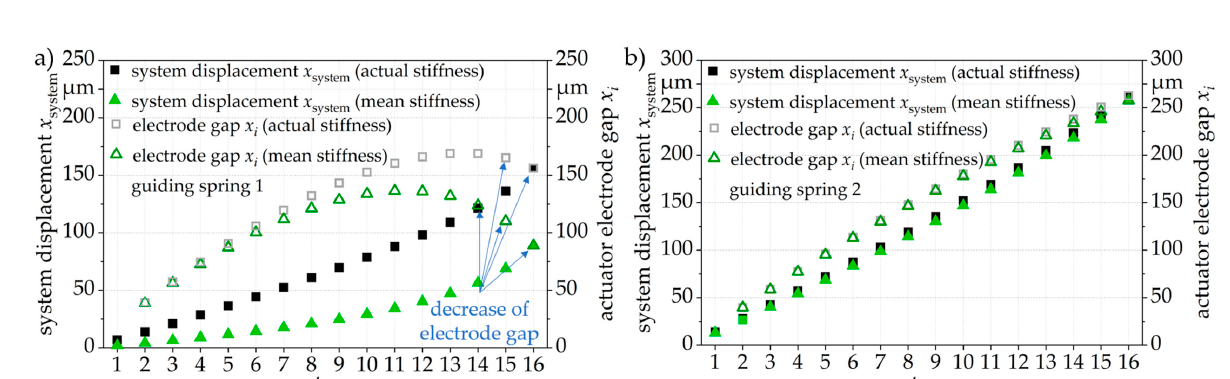
Figure 5. System displacement and electrode gap distance of 16-step systems depending on mean and actual stiffness value design guided by ( a ) guiding spring 1 (actual stiffness value: system 7 presented in Table 1), ( b ) guiding spring 2 (mean stiffness value: system 6 presented in Table 1). The values are obtained analytically (Equations (2) and (3)) by calculating with the spring stiffness values that are obtained by COMSOL simulation. The electrode gap amounts to 20 µm for each actuator.